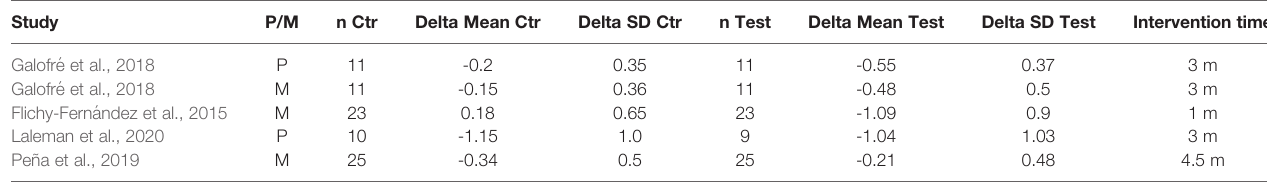
TABLE 4 | Changes in probing pocket depth in the control and test groups in the studies included in the meta-analysis in Figure 3 . Study